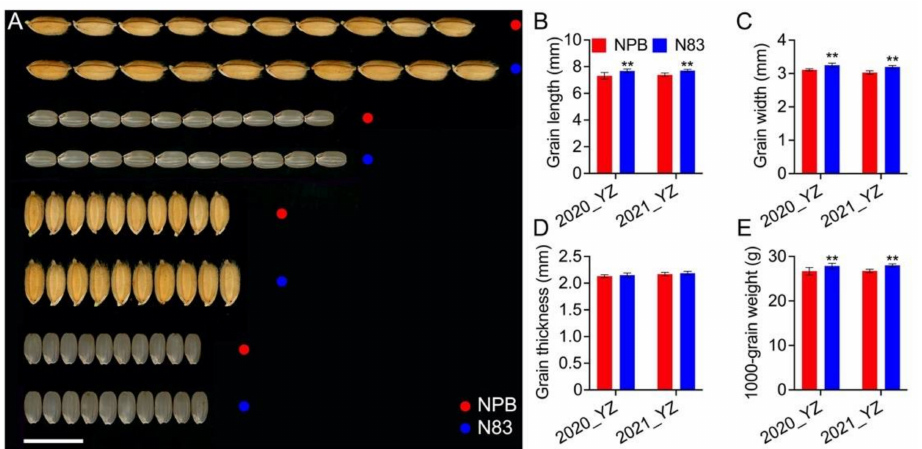
Figure 1. Graphical genotypes of NPB, N83, and 93-11. Twelve chromosomes are represented by vertical bars and numbered at the top. In the N83 chromosomal maps, the black regions indicate the 93-11 segments in the NPB background, and the red region indicates the region containing the qTGW7 locus, as previously reported.